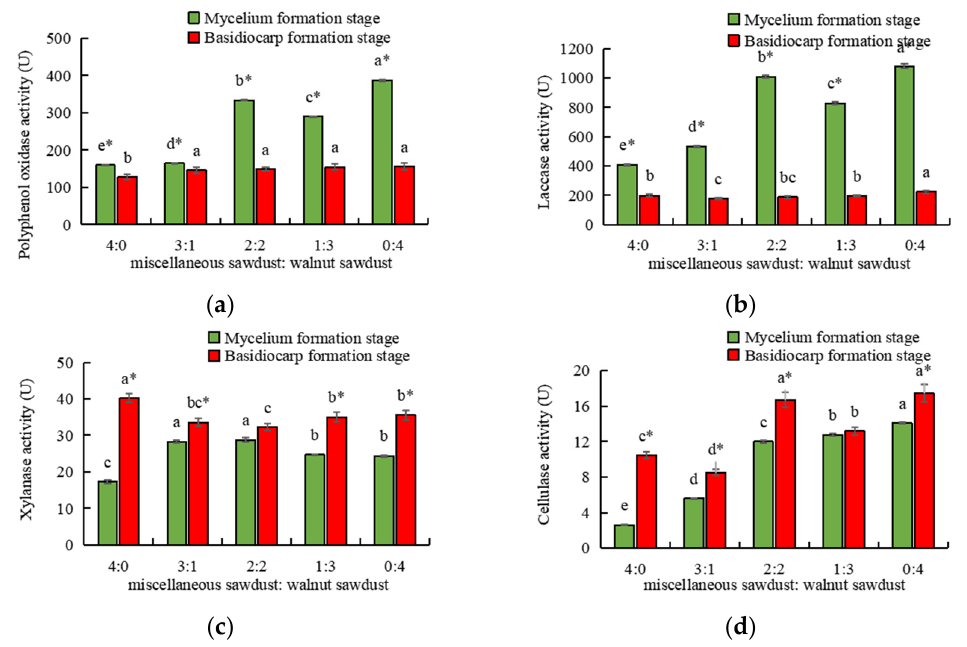
Figure 2. Effects of different walnut supplemental levels on extracellular enzyme activity of ( a ) polyphenol oxidase; ( b ) laccase; ( c ) xylanase; ( d ) cellulase during mycelium and basidiocarp formation stage. Different lowercase letters within each column are significantly different at p < 0.05 between treatments. * is significantly different at p < 0.05 between the formation stage.